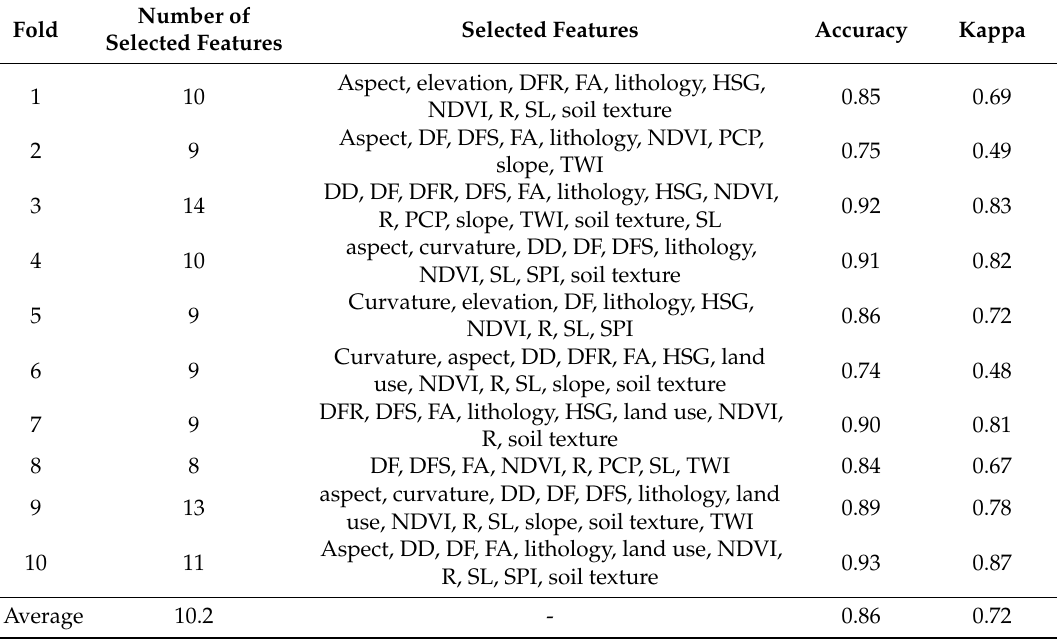
Table 2. Selected factors in each fold using the simulated annealing feature selection (SAFS) method.